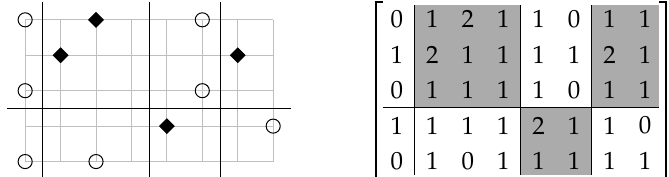
Figure 4. Example instance of O PTIMAL D ISCRETIZATION ( left ) and the corresponding instance of C ONSECUTIVE C O -C LUSTERING ∞ ( right ). The point set consists of white (circles) and black (diamonds) points. A solution for the corresponding C ONSECUTIVE C O -C LUSTERING ∞ instance (shaded clusters) naturally translates into a consistent set of